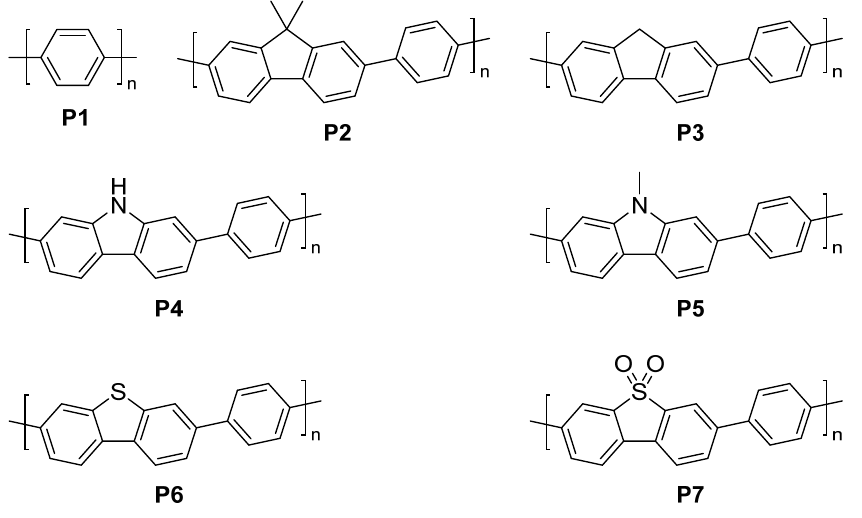
Figure 6. First examples of polar polymer photocatalysts [56].